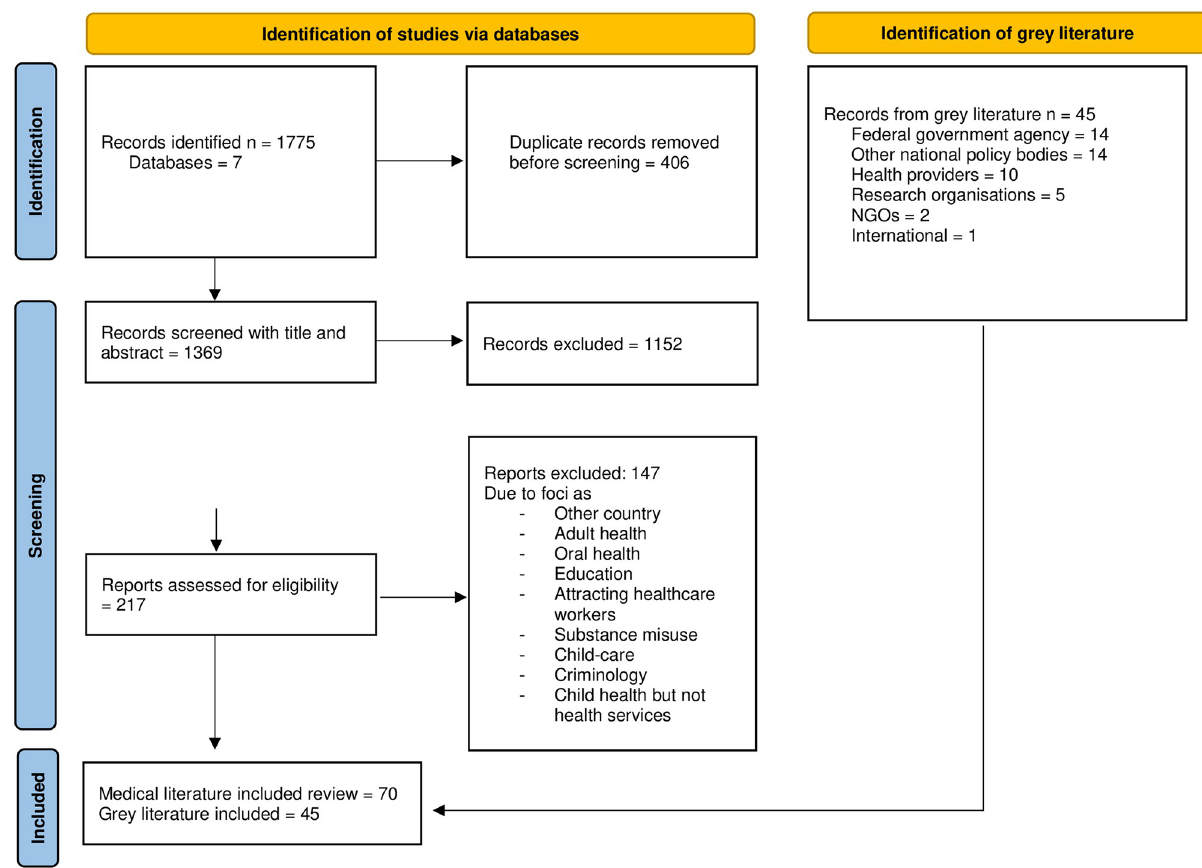
Fig 1. PRISMA flowchart of peer-reviewed and grey literature. Adapted from: Page MJ, McKenzie JE, Bossuyt PM, Boutron I, Hoffmann TC, Mulrow CD, et al. The PRISMA 2020 statement: an updated guideline for reporting systematic reviews. BMJ 2021;372:n71. doi: 10.1136/bmj.n71.